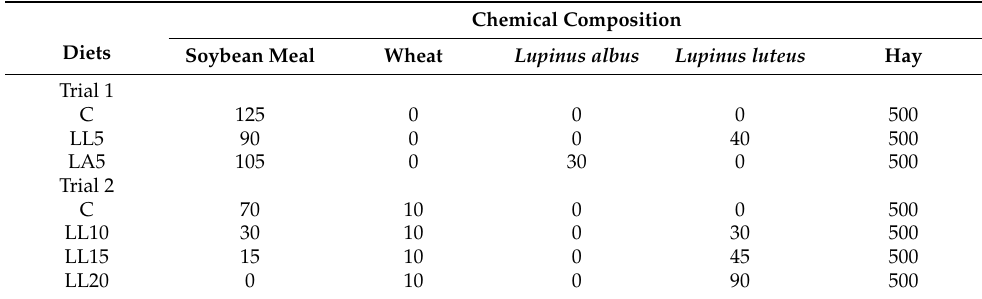
Table 3. Levels of components (g/kg as fed) ingested during the digestibility trials.